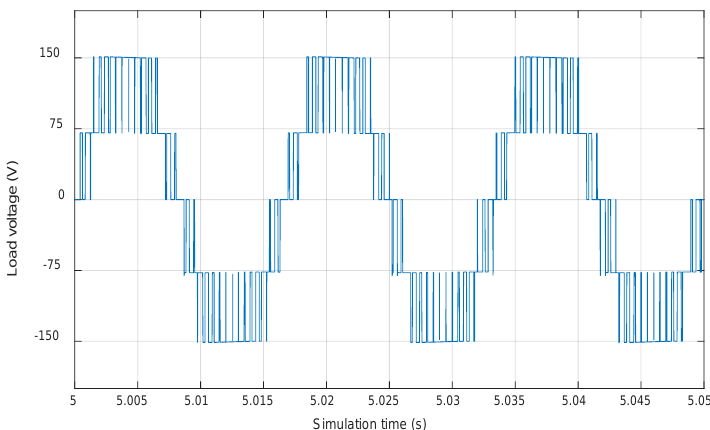
Figure 8. Waveform of the load voltage.